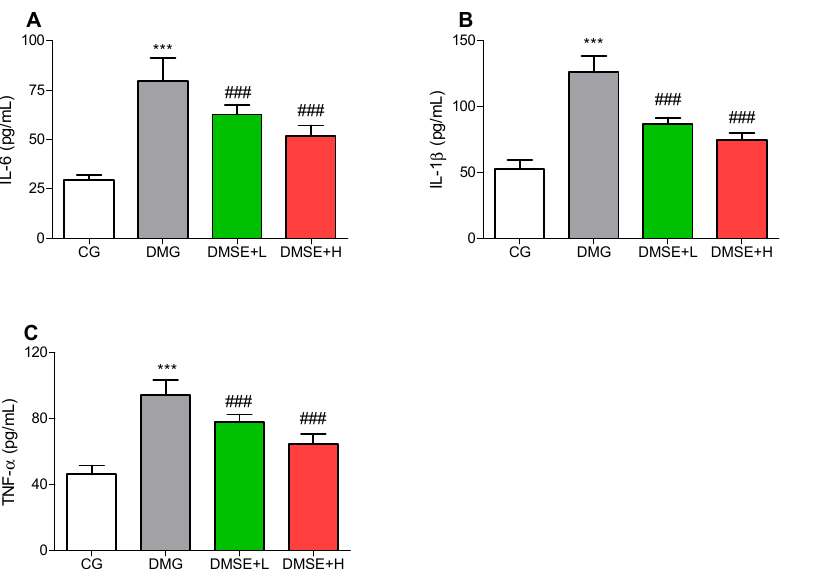
Figure 5. Effect of MSE on proinflammatory cytokines in the brain of diabetic rats ( A ) IL-6, ( B ) IL-1 β and ( C ) TNF- α . Data represent mean ± SD. *** p < 0.05 when compared to the control group. ### p < 0.05 when compared to the diabetic group.